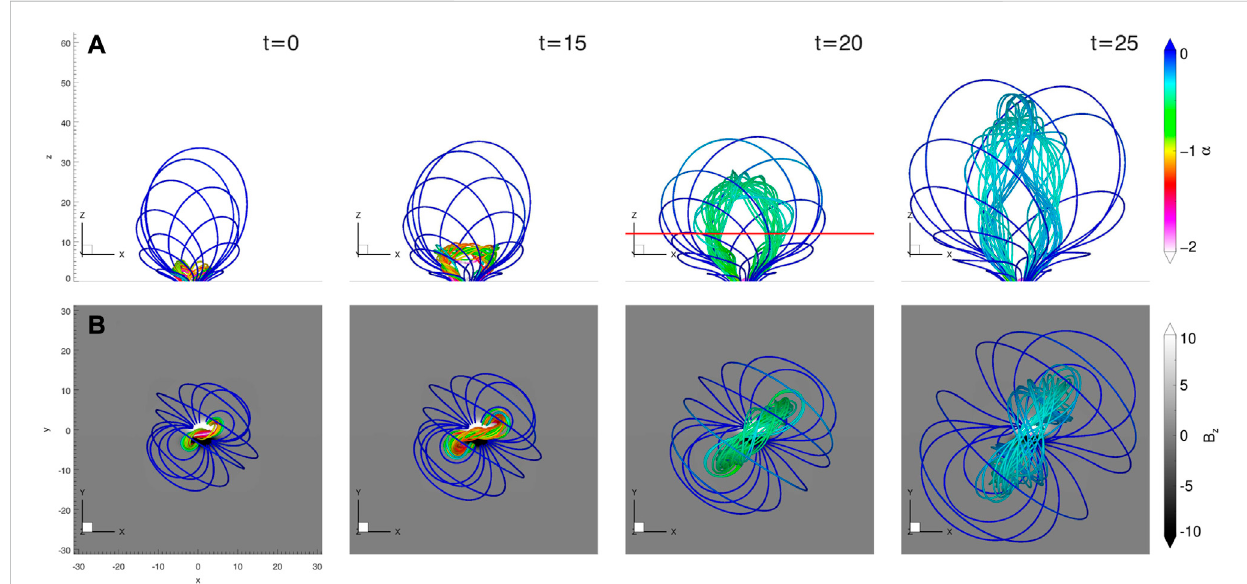
FIGURE 1 Structural evolutionoftheeruption. (A) 3Dperspectiveview ofmagnetic fi eldlines coloredbytheforce-free factor.Herethe fi eldlinesaretraced at fi xed footpoints on the bottom surface, and they represent the core structure of the MFR and its ambient magnetic fi eld. At t = 20 t s , a red horizontal line gives the location of the slice in Figure 3A. (B) Top view of the structure is shown in (A) . The unit of time is 105 s. Also, see Supplementary Movie S1 for a high-cadence evolution of the eruption